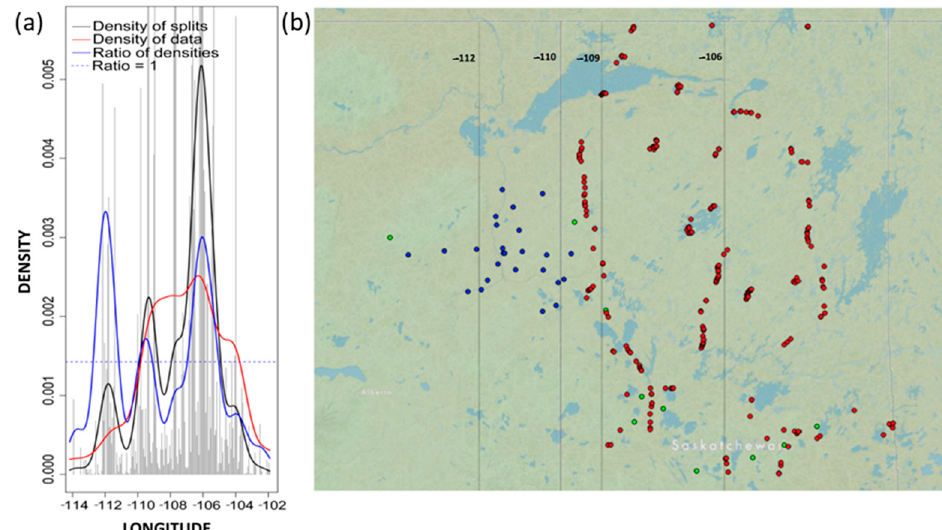
Figure 4. ( a ) Densities plot for longitude with binned split importance values (grey histogram bars), the density of data (red line), the density of splits (black line), the ratio of split-over-density (blue line). The dashed line is where the ratio = 1. Relatively greater community level changes (high split importance values) occur when the ratio of densities > 1; and ( b ) map of study sites across Alberta and Saskatchewan (n = 297), with vertical black lines indicating longitude values where gradien forest identified thresholds.